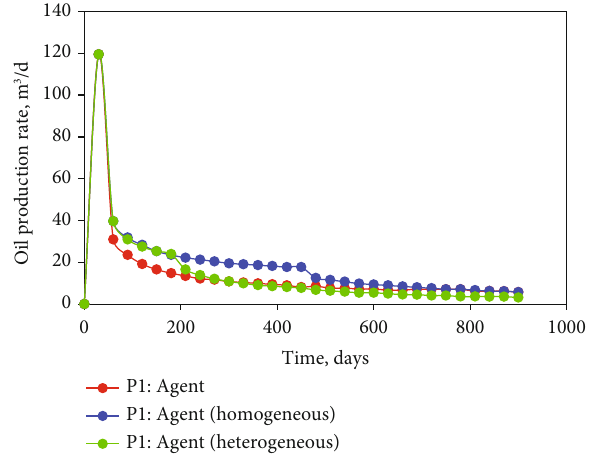
Figure 7: Oil production rates generated by di ff erent models.